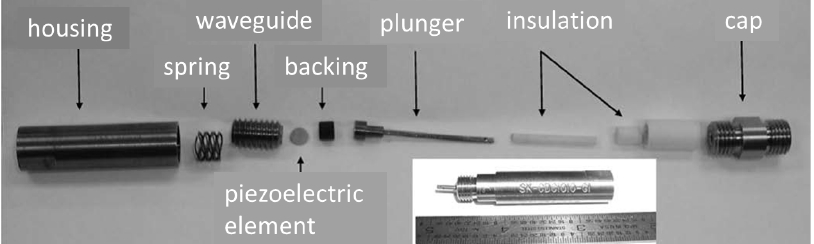
Figure 14. Photograph of the ultrasound transducer and fixture assembly [85] (copyright 2013 by the IEEE).